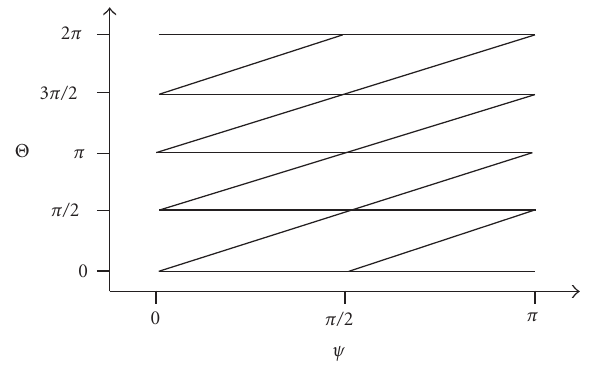
for t 1, γ on T ∗ 1 H . Dotted vectors represent θ − ψ = j ( π/ 2). 0 0